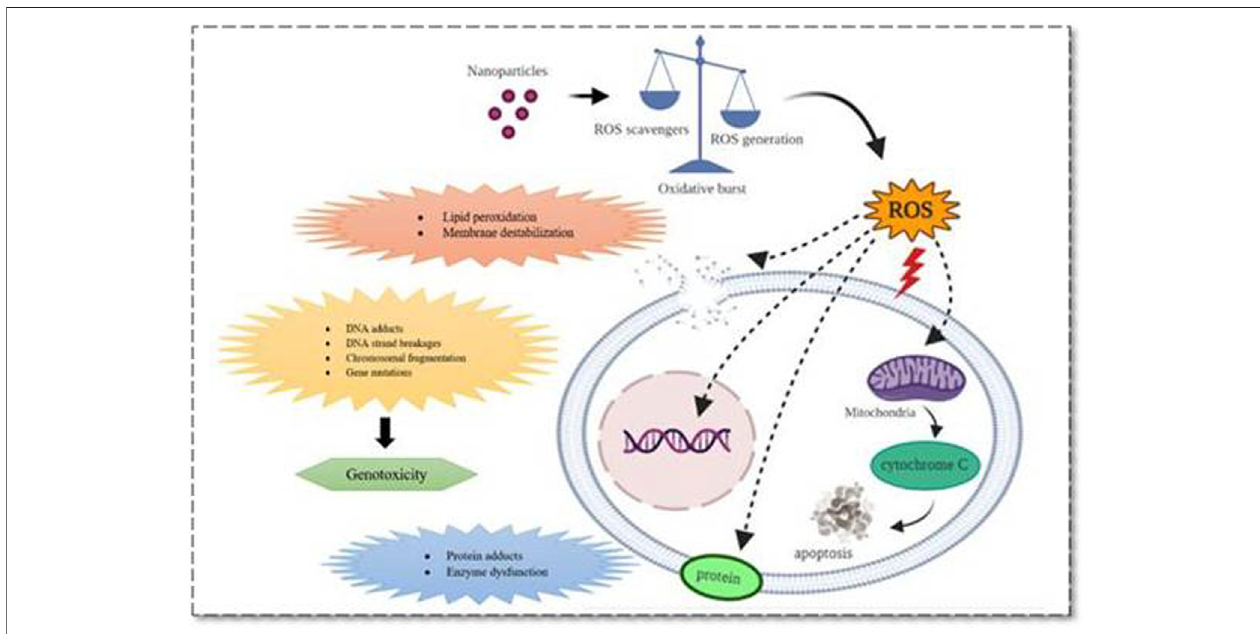
FIGURE1| Variousmechanisticpathways(molecularlevel)thatcanalterthephysiologicalfunctioningofcellsuponnanoparticleinteractionwhichcaneitherinduce or release cell damage constituents. These mechanistic pathways that crosstalk with various organs and cells including immune cells and thus regulate pathogenesis, progression, and death of a cell were